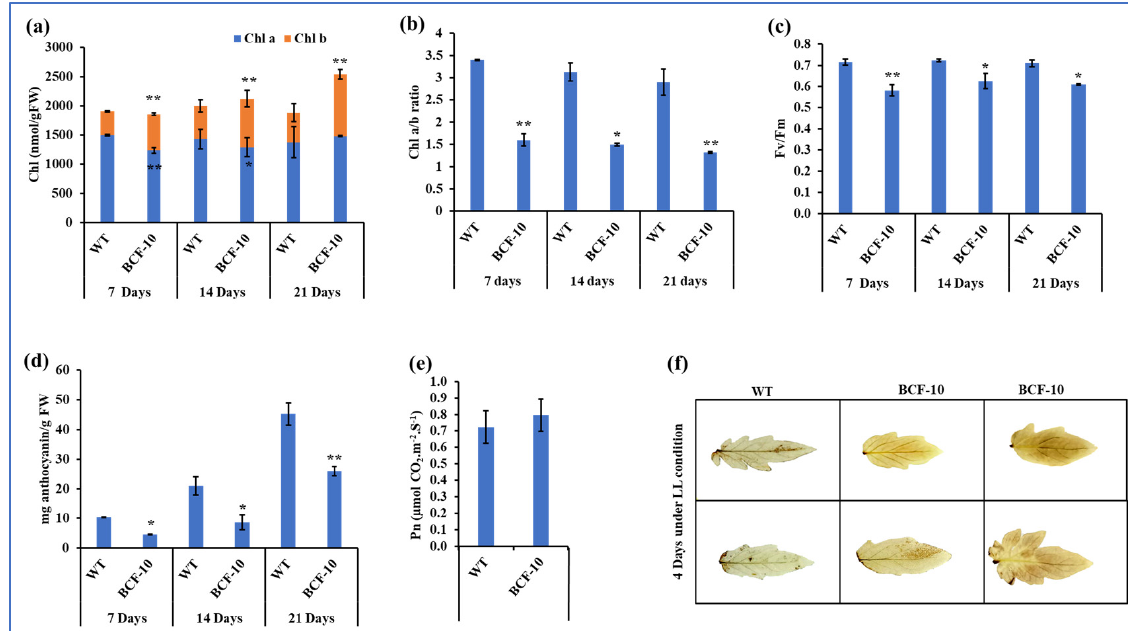
Figure 4. Pigments, photosynthetic rate, and H 2 O 2 accumulation of WT and BCF − OE plants under LL conditions. ( a ) Chl a and Chl b content, ( b ) Chl a/b ratios, ( c ) Fv/Fm values, and ( d ) anthocyanin content of WT and BCF − OE plants in different stages of LL treatment. ( e ) Net photosynthetic rate (Pn) was measured after 14 days at LL growth conditions. ( f ) H 2 O 2 accumulation, detached leaves of WT, and BCF − OE plants were exposed to LL for 2 and 4 days and stained with 3,3 − diaminobenzidine (DAB). The data point is the average of six replicates, and SE represents the standard error. Asterisks indicate a significant difference compared to WT (Student’s t − test, * p < 0.05, ** p < 0.01).